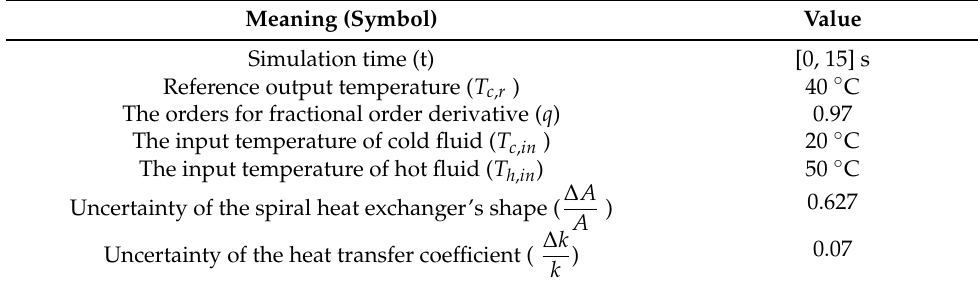
Table 2. Simulation condition of the spiral-plate heat